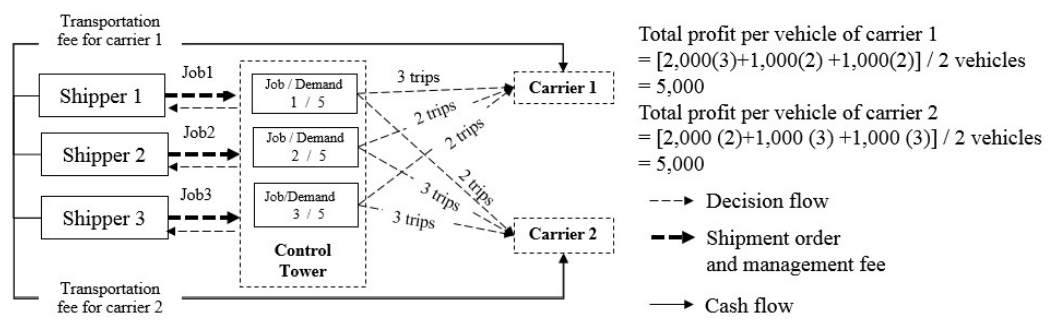
Fig. 1. An example of BT and profit allocation for two carriers with three jobs from three